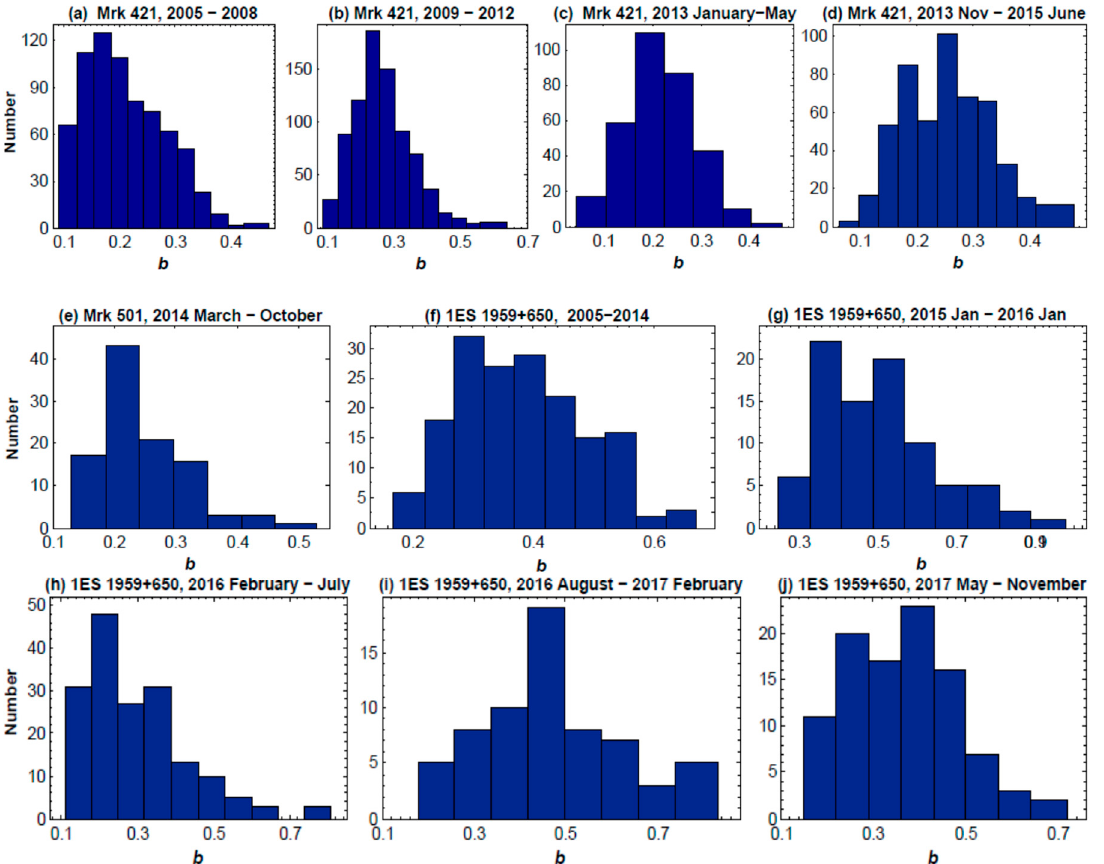
Figure 4. The distribution of the values of the curvature parameter correlation for Mrk 421 ( a – d ), Mrk 501 ( e ) and 1ES 1959+650 ( f – j ) observed with Swift-XRT in different periods (reproduced from References [24–32]).